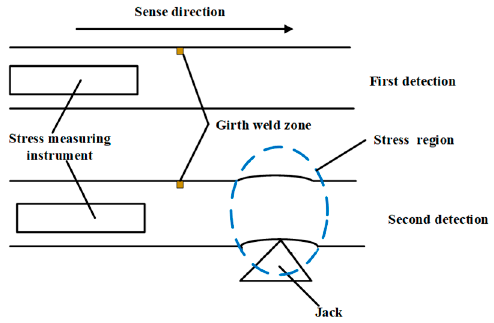
Figure 25. Principle diagram of the traction test.